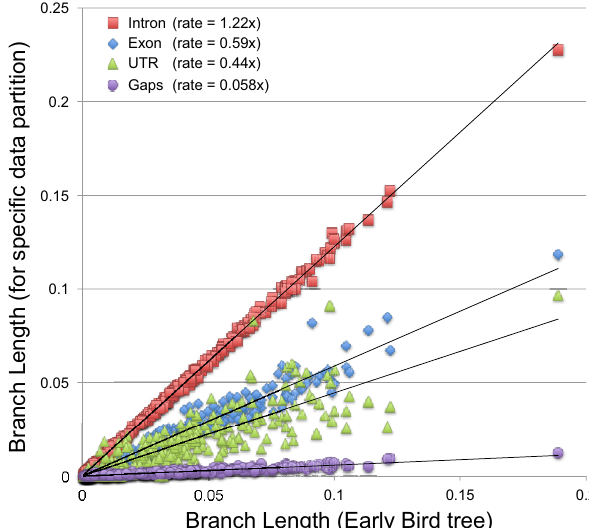
Figure 2. Branch lengths estimated from gap data (using the (cid:38)(cid:41)(cid:49)(cid:89)(cid:14)(cid:299) model) plotted against branch lengths from all nucleotide data (estimated using the (cid:42)(cid:55)(cid:53)(cid:14)(cid:44)(cid:14)(cid:299)(cid:3) (cid:80)(cid:82)(cid:71)(cid:72)(cid:79) ). Branch length estimates for specific nucleotide partitions (introns, coding exons and 3' untranslated regions [UTRs]) are presented for comparison of relative rates (next